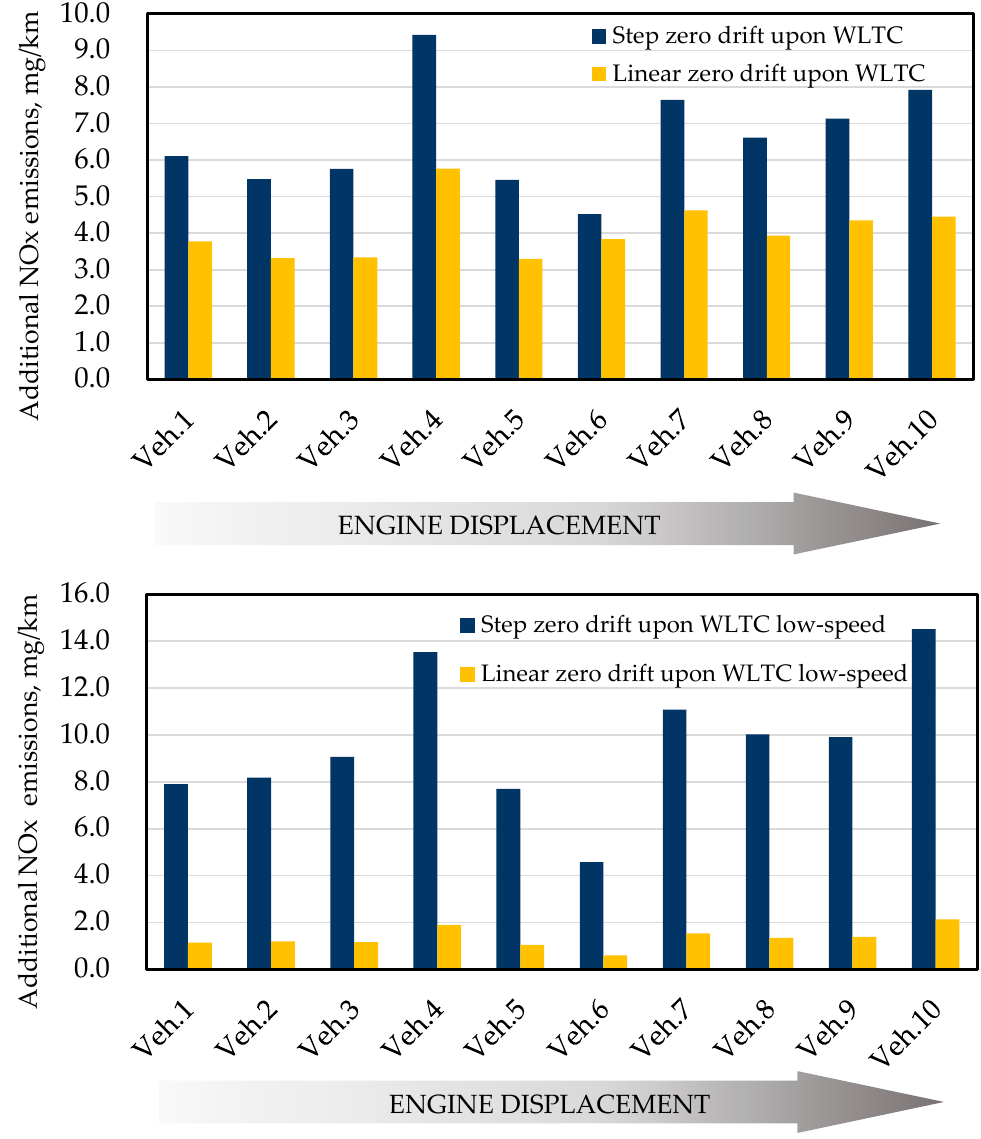
Figure 4. Step and linear zero drift over the WLTC and its urban section.